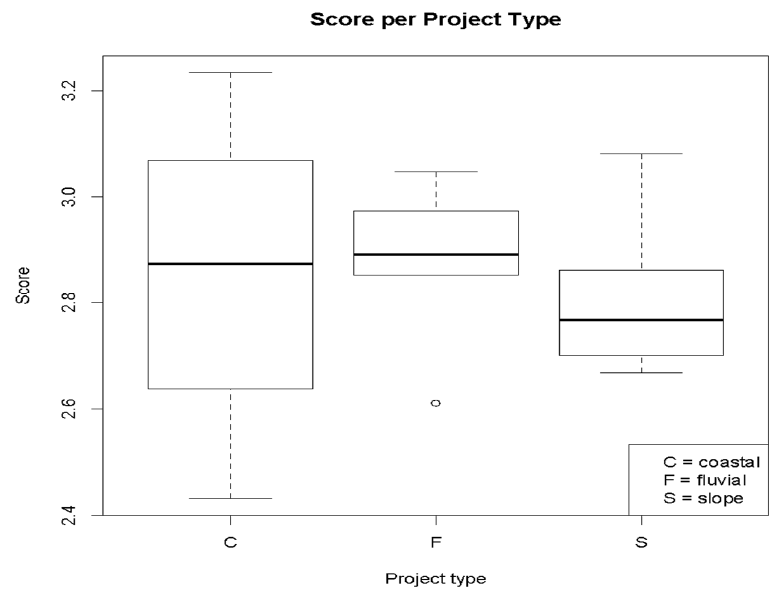
Figure 7. Overall average sustainability performance score per case study type. Baseline sustainability score is 3.0. The lower edge of the box corresponds to the 25th percentile data point, while the top edge of the box corresponds to the 75th percentile data point. The line within the box represents the median. The highest and lowest scores excluding outliers are shown in the upper and lower whiskers. An outlier was observed at ca. 2.6 in Fluvial projects (F).